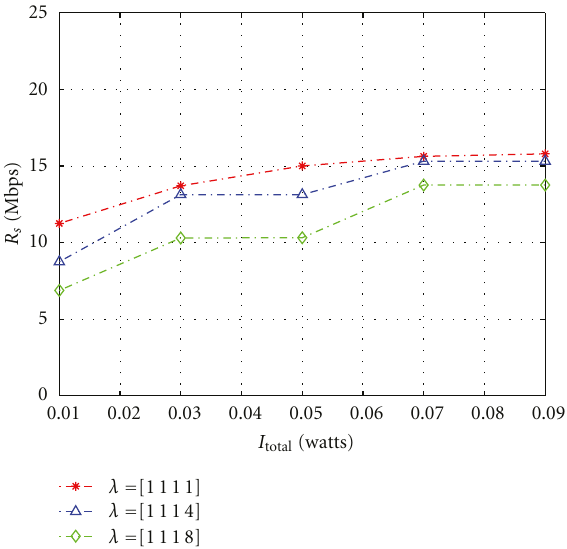
Figure 7: Average total CRU bit rate, R s , versus maximum PU tolerable interference power, P total , with P total = 25 W, P m = 5 W, and ρ = 0 .